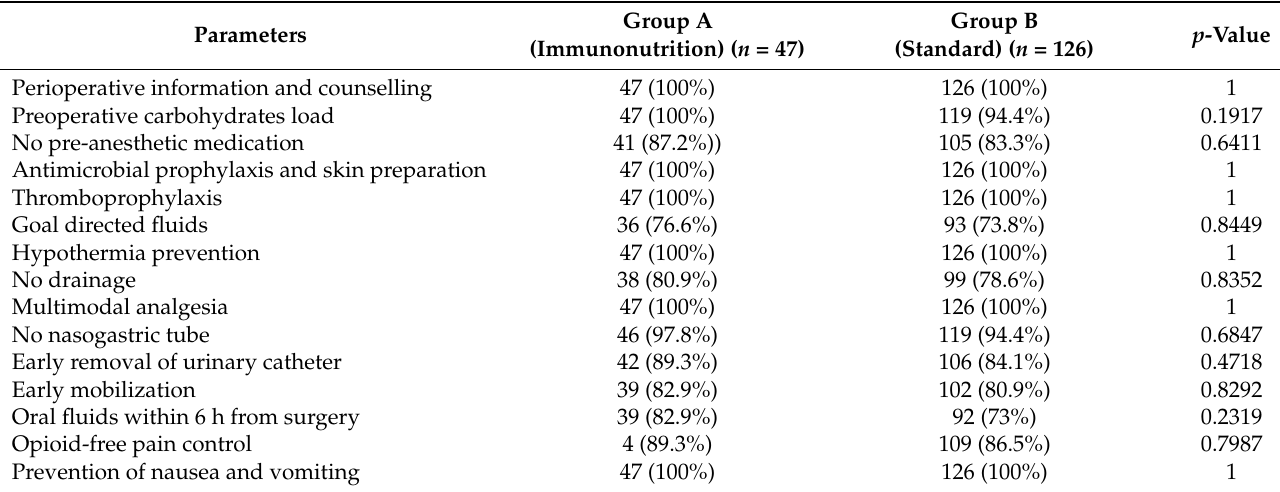
Table 4. Compliance with ERAS protocol.